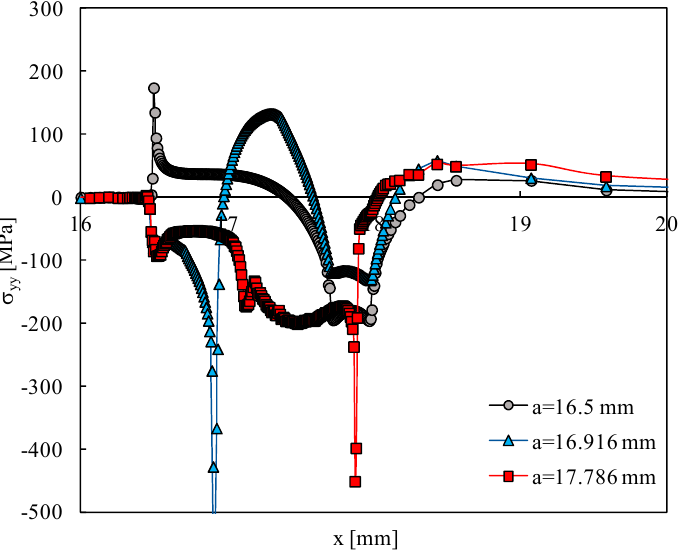
Figure 3. Effect of crack propagation on residual stresses.